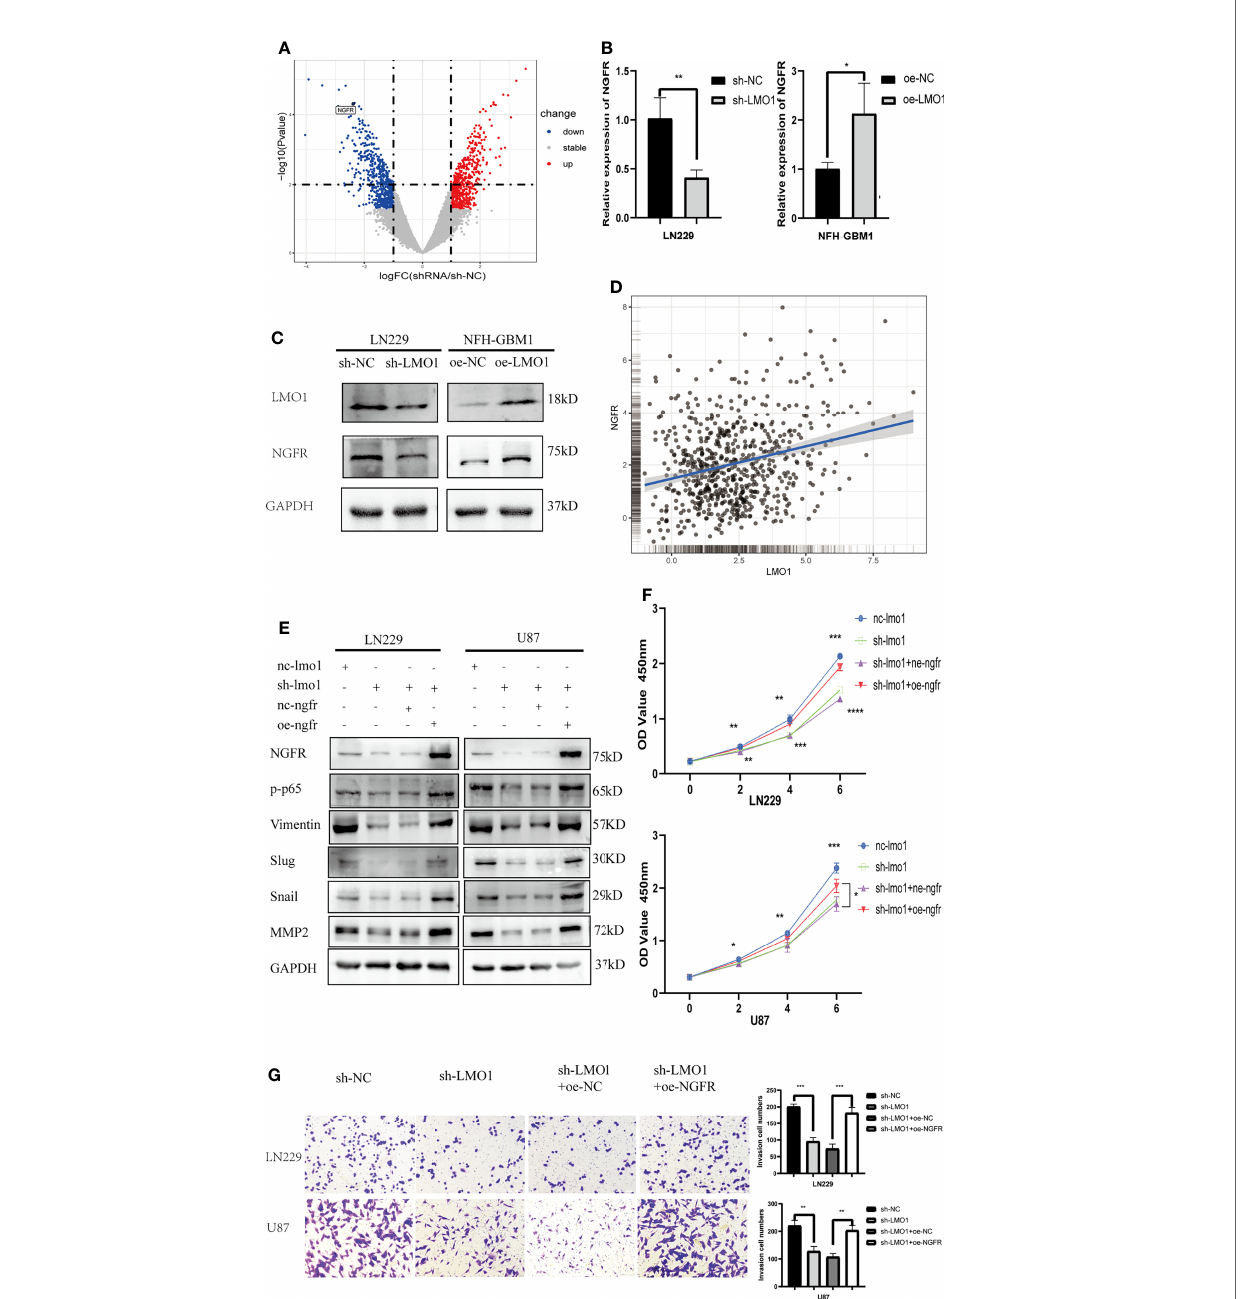
FIGURE 5 | LMO1 promotes the glioma progression by regulating NGFR transcription and NF- k B activation. (A) Three independent LMO1 reduced and control cells were prepared for RNA preparation and RNA-Seq analysis. Genes with altered expression were displayed in volcano plots. The upregulated genes are highlighted in red and downregulated genes in blue. Student ’ s t test was used for statistical analysis. (B) LN229 cells were transfected with speci fi c sh-RNA of LMO1 or negative sh-RNA (sh-NC),while NFH-GBM1 cells were transfected with the plasmaid overexpressing LMO1 or empty plasmid. RT-PCR was used to detect the NGFR mRNA level. Student ’ s t test was used for statistical analysis. (C) glioma cells were prepared as (B) , western blot was used to detect NGFR protein level. (D) Scatter plot of the expression of LMO1 and NGFR in a CGGA dataset. Pearson correlation analysis was used for statistical analysis. (R = 0.26 P < 0.001). (E) LN229 and U87 cells were transfected with lentivirus of LMO1 KD or NGFR overexpression plasmid or co-transfected them together. Western blot analysis was used to detect NGFR, p- p65, Vimentin, Slug, Snail and MMP2 protein levels. (F) Recovery cck8 assays with the indicated LN229 and U87 cell lines. ANOVA was used to calculate the p- value. (G) Recovery Transwell assays with the indicated LN229 and U87 cell lines. Original magni fi cation, 400×. Five random fi elds of view were captured for each group. Student ’ s t test was used to calculate the p-value. *p < 0.05. **p < 0.01. ***p < 0.001. ****p <